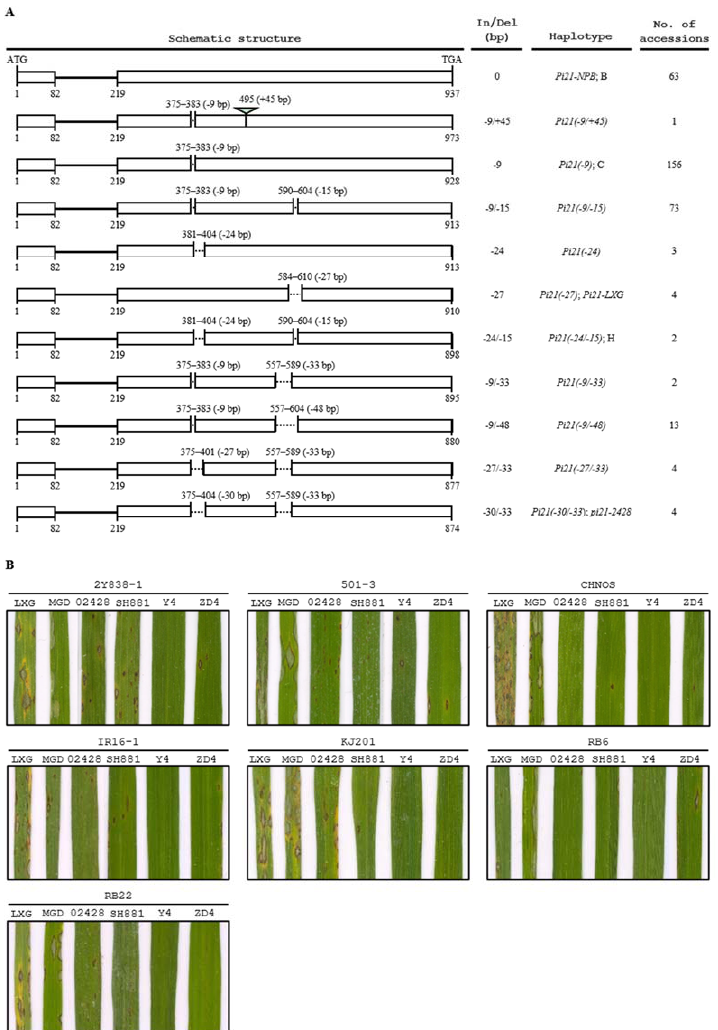
Figure 5. Assessment of haplotypes of Pi21 in 325 rice accessions and blast inoculation of the pi21-2428 -containing varieties. ( A ) A total of 11 haplotypes were identified among 325 rice accessions. The haplotypes were named based on insertion / deletion patterns. Pi21-NPB , Pi21(-9) , and Pi21(-24 / -15) were identical to the previously identified haplotypes B, C, and H, respectively [16]. Open boxes represent exons, lines represent introns, and dotted lines represent deletions. Numbers above the diagrams indicate positions of deletions corresponding to the Pi21-NPB allele, and numbers below the diagrams represent the start and end nucleotide positions of exons of each allele. ( B ) Phenotypes of the pi21-2428 -containing varieties 02428, ShuHui881 (SH881), Yong4 (Y4), and ZhengDa4Hao (ZD4) inoculated with M. oryzae isolates 2Y838-1, 501-3, CHNOS, IR16-1, KJ201, RB6, and RB22, respectively. Rice varieties LXG and MengGuDao (MGD) were used as highly susceptible